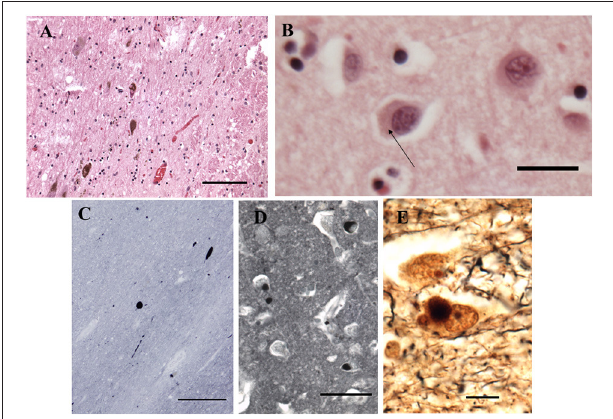
FIGURE 4 | Histopathological findings from the case study. (A) Substantia Nigra. H&E. Disintegration of pigmented neurons, with Lewy bodies in two of those remaining (center and lower left). Bar = 100 microns. (B) Frontal cortex. H&E. A Lewy body is seen in the central neuron as a perinuclear region of increased eosinophilia (arrow). Bar = 20 microns. (C–E) Immunohistochemistry for α -synuclein. (C) Substantia nigra pars compacta. Inclusions are seen in cell bodies and neurites. Bar = 200 microns. (D) Hilus (CA3) of hippocampus. Bar = 50 microns. (E) Bielschowsky stain, hippocampus. Central neuron contains a Lewy body. Bar = 10 microns.